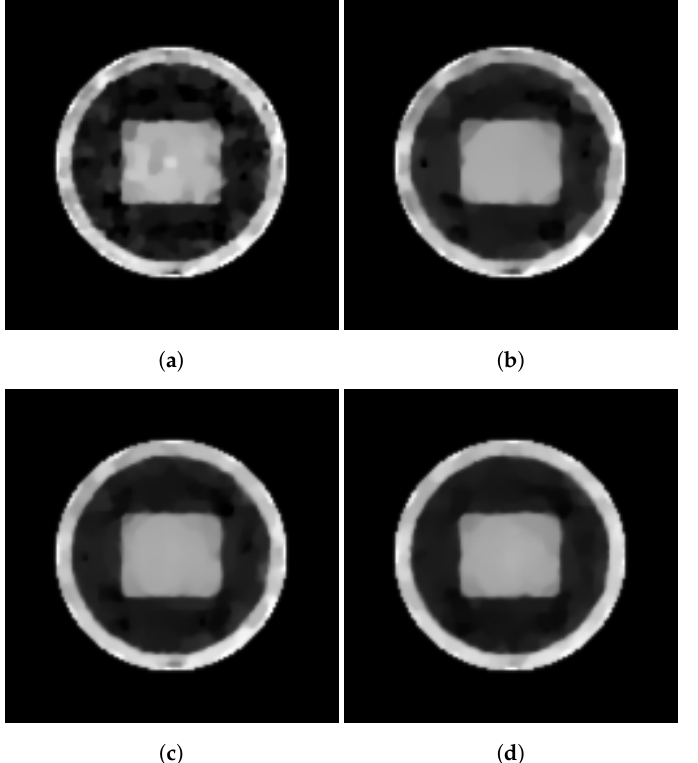
Figure 9. ( a ) Figure 8f without the ballistic contribution; ( b ) Derivatives of ( a ).